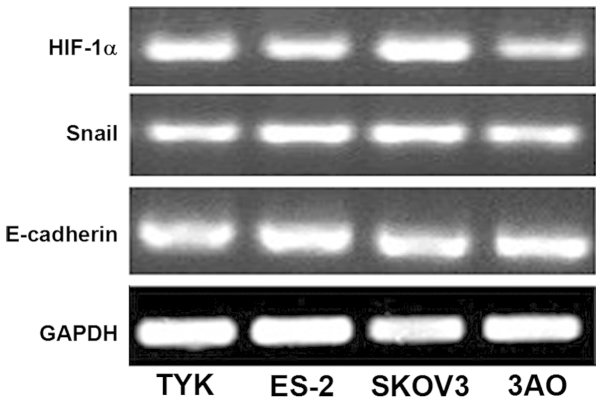
mRNA expression of the HIF-1α, Snail and E-cadherin genes in ovarian cancer cells. Reverse transcription polymerase chain reaction analysis of HIF-1α, Snail and E-cadherin in TYK, ES-2, SKOV3 and 3AO ovarian cancer cell lines; GAPDH levels were used as control for integrity of RNA samples. HIF-1α, hypoxia-inducible factor-1α.